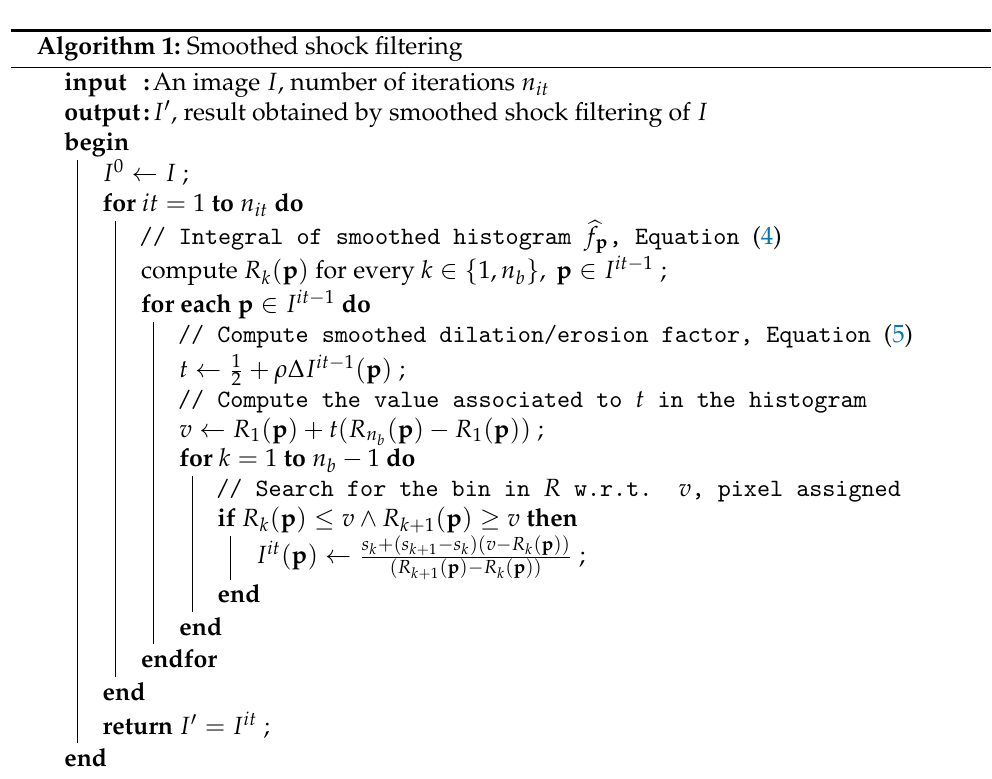
Algorithm 1: Smoothed shock filtering